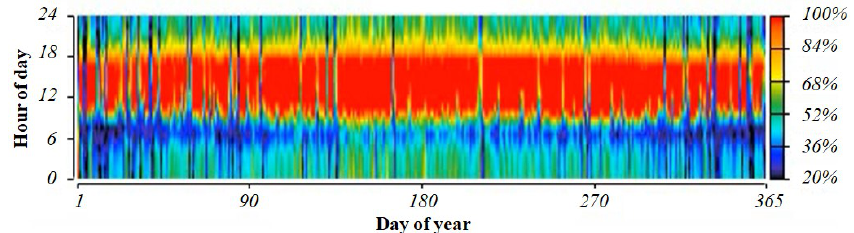
Figure 18. Yearly SOC profile of battery for PV-Wind-BSS-DG configuration.